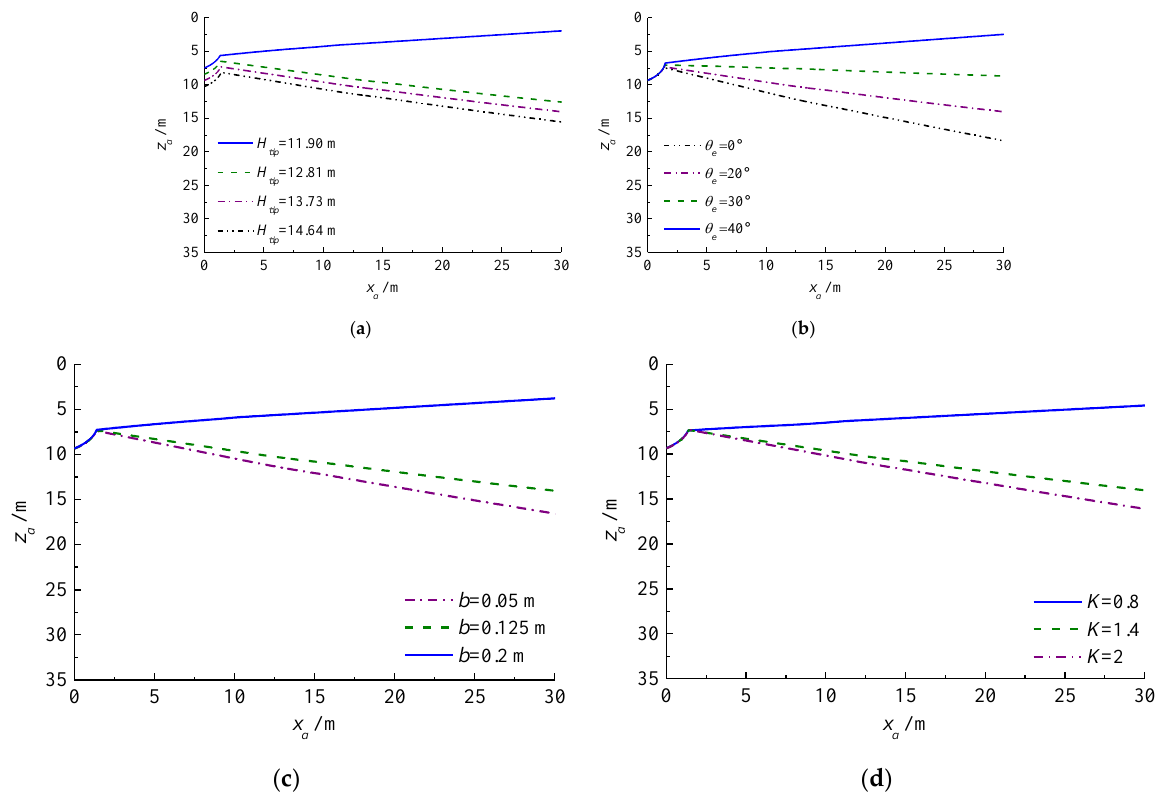
 ; ( c ) H ; ( b ) Effect of e tip